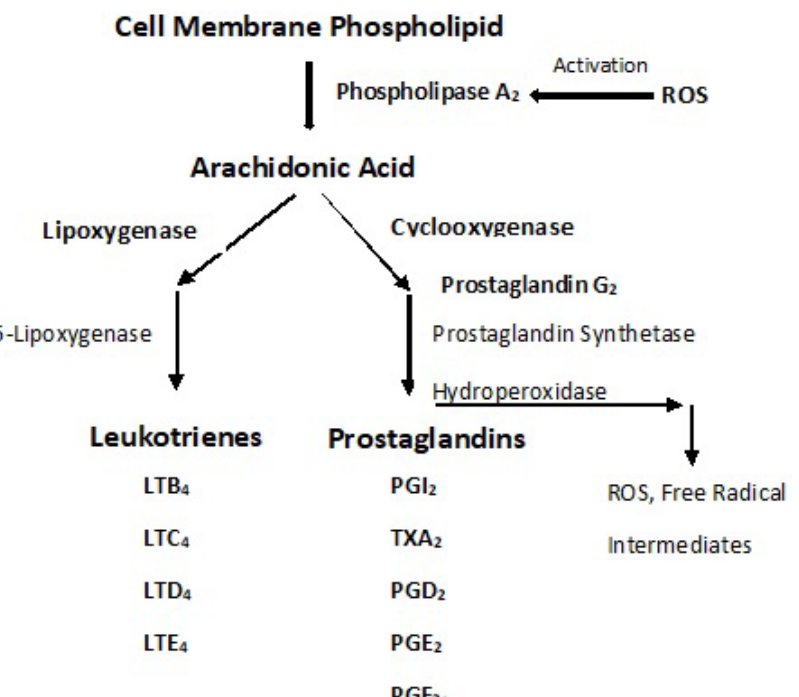
Figure 10. Pro-Inflammatory Leukotrienes (LT) and Prostaglandins (PG) Metabolized from Arachidonic Acid (AA). Isoforms of phospholipase A 2 have been reported to be activated by ROS [63]. phospholipase A 2 cleaves AA from cell membrane phospholipids. AA is oxidized through the lipoxygenase pathway to yield leukotrienes, eicosanoid inflammatory mediators, which are released by macrophages and are involved in the inflammatory reactions [64]. LTB 4 is a potent chemotactic agent. The prostaglandins are derived from AA and metabolized through the cyclooxygenase pathway. They are involved in the inflammatory response as well as other pathogenic mechanisms [65]. PGE 2 is a potent pro-inflammatory PG and is involved in all the signs of inflammation, although it also can exert anti-inflammatory effects during neuroinflammation.